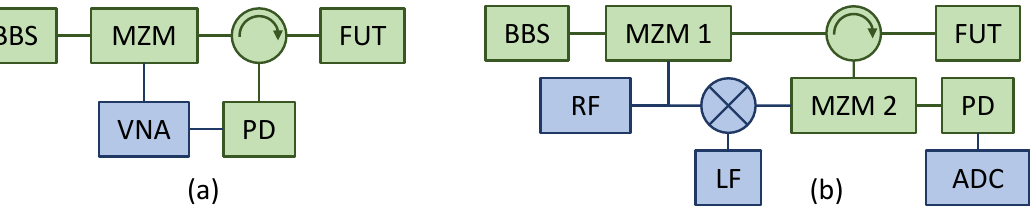
Figure 1. Schemes of stepped-frequency I-OFDR systems based on ( a ) vector network analysis; and ( b ) electro-optic downconversion. Photonic components are represented in green; RF and electronic components in